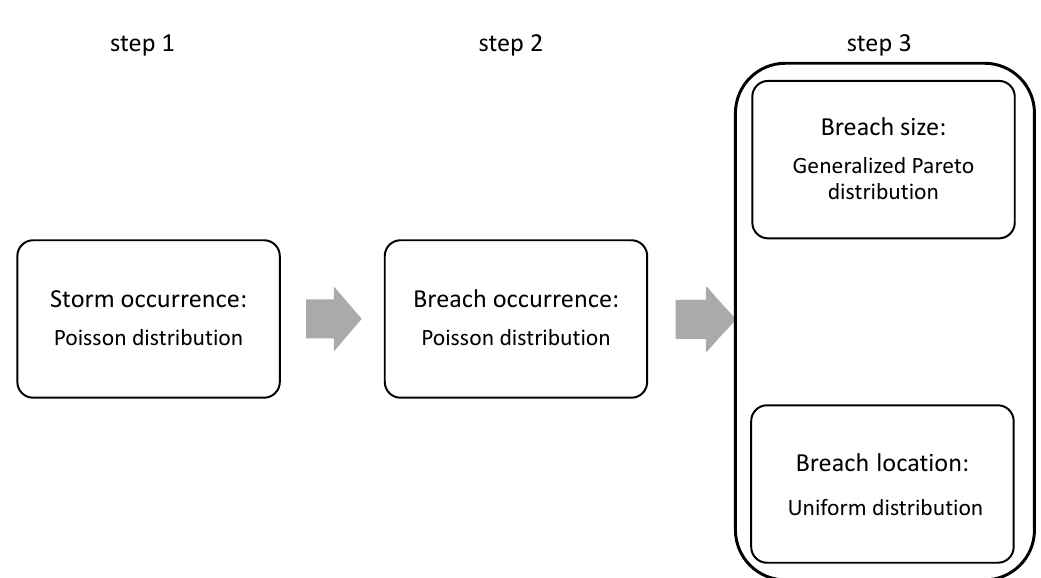
Figure 3. Diagram showing the procedure used in our stochastic shell to determine if storm-induced breaches are forced and what their characteristics will be. Further explanation in Section